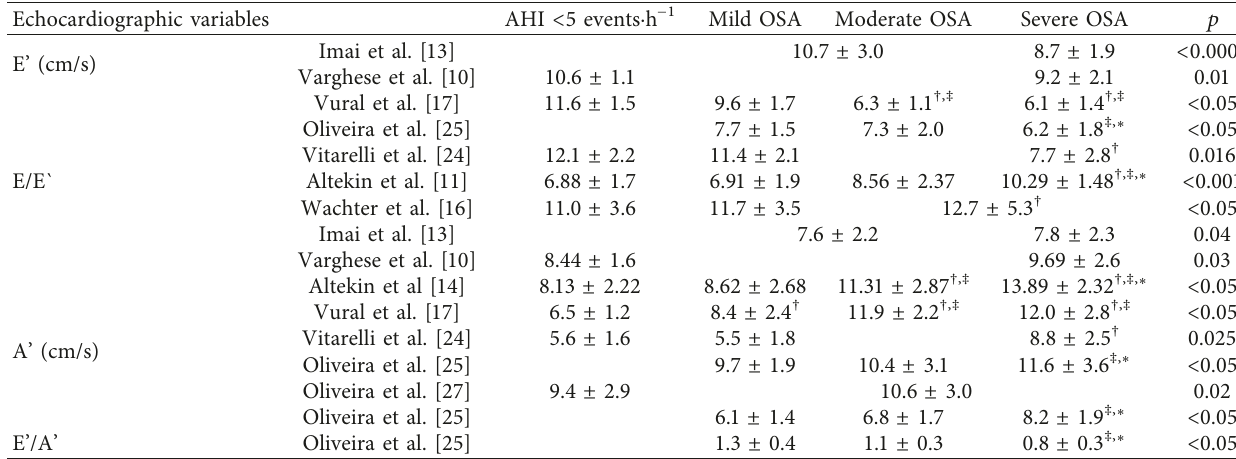
Table 6: Left ventricular tissue Doppler parameters in patients with OSA. Echocardiographic